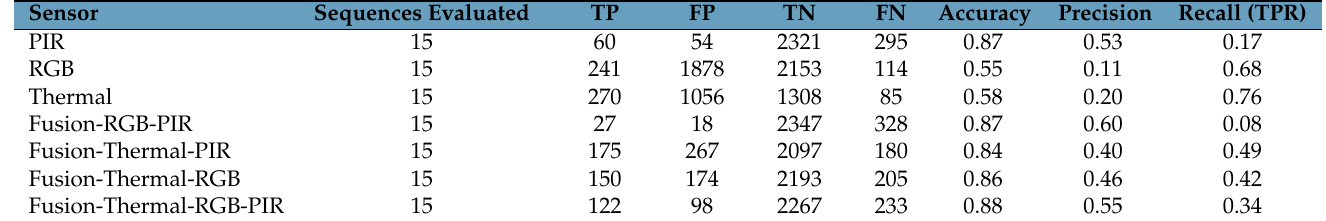
Table 4. Comparison of confusion matrices using single sensor detections and fusion of combined sensor detections for all